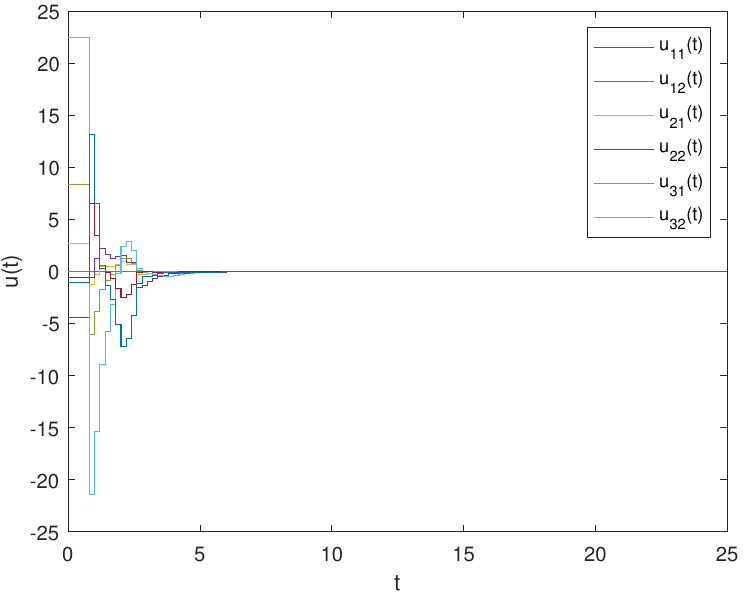
Figure 5. The state trajectory manuscript of the improved event-triggering control input in Ex- ample 1. Under the improved event-triggered control, the state trajectory of the control input variables was